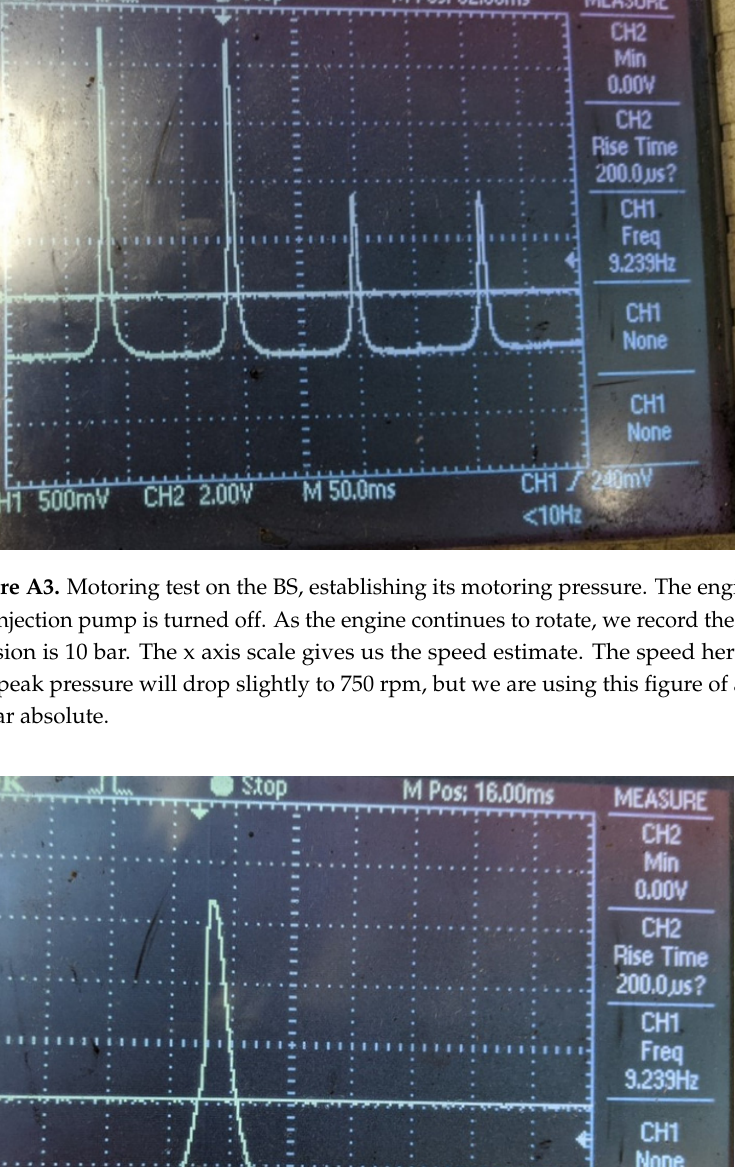
Figure A4. First case of new BSL data with advanced injection timing, equivalent to Case 2. Pre- mixed combustion starts at 24–25 bar absolute, which is about 2–3 bar below the motoring pres- sure. This is how we know that the injection is advanced. Note that the peak cylinder pressure in this case is about 55 bar. The engine was not fully warmed up yet. When we reached 70 °C, the reduced friction allowed the peak pressure to drop down to 44.5 bar gage or 45.5 bar absolute.